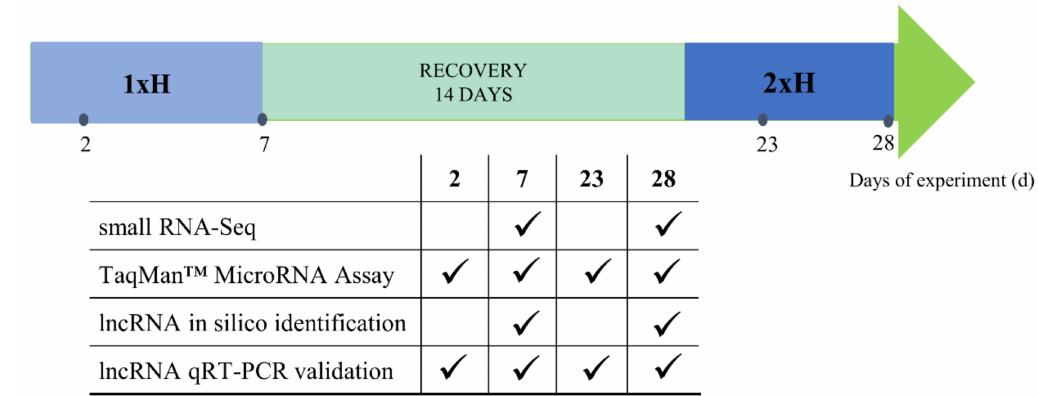
Figure 14. A scheme describing the experiment duration and time-points (days) of sample collection for small RNA-Seq assay, TaqMan TM MicroRNA Assay, lncRNA in silico identification and lncRNA validation by